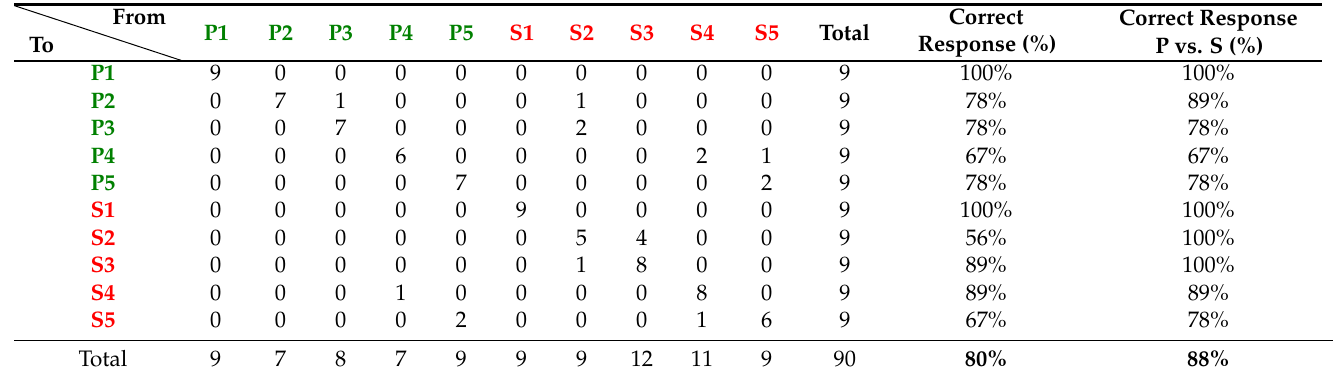
Table 3. Confusion matrix of the Pasture and Stall goat’s milk